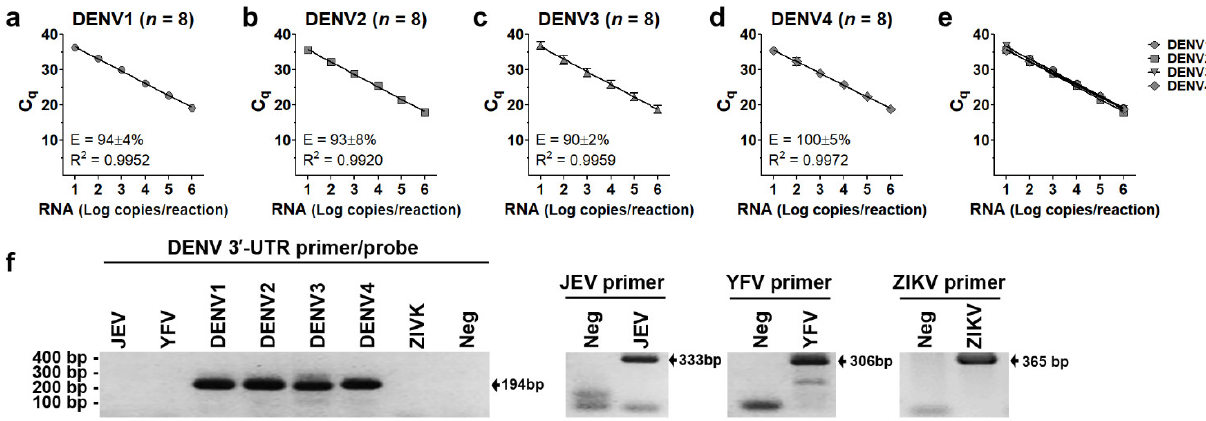
Figure 1. Performance of 3′-UTR primers/probes. Quantification cycle (Cq) of 3′-UTR region ( a – e ) was determined using serial 10-fold diluted (10 1 to 10 6 RNA copies) in vitro transcript DENV1- 4RNA as template. Coefficient of determination (R 2 ) and PCR amplification efficiency (E) for DENV1 ( a ), DENV2 ( b ), DENV3 ( c ), and DENV4 ( d ) were analyzed from 8 independent experiments. The variation of Cq values at each RNA concentration among serotypes was analyzed by Bonferroni’s Multiple Comparison Test ( e ). RNAs extracted from cultured supernatants of Japanese encephalitis virus (JEV, Nakayama strain), yellow fever virus (YFV, 17D strain), zika virus (ZIKV, ZV0127 strain), DENV1 Hawaii, DENV2 16681, DENV3 H87, and DENV4 H241 were used as RNA templates to verify the specificity of our 3′-UTR primers/probes ( f ). Primers specific to E gene of JEV, YFV, or ZIKV were used to confirm the existence of RNA templates of each virus type. The sizes of PCR products for DENV1, DENV2, DENV3, DENV4, JEV, YFV, and ZIKV were 185, 187, 184, 189, 333, 306, and 365 base pairs, respectively. No RNA template (Neg) was used as a negative control. The PCR product was run in 2% agarose gel electrophoresis and was stained with gel red before visualization under UV light ( f ).